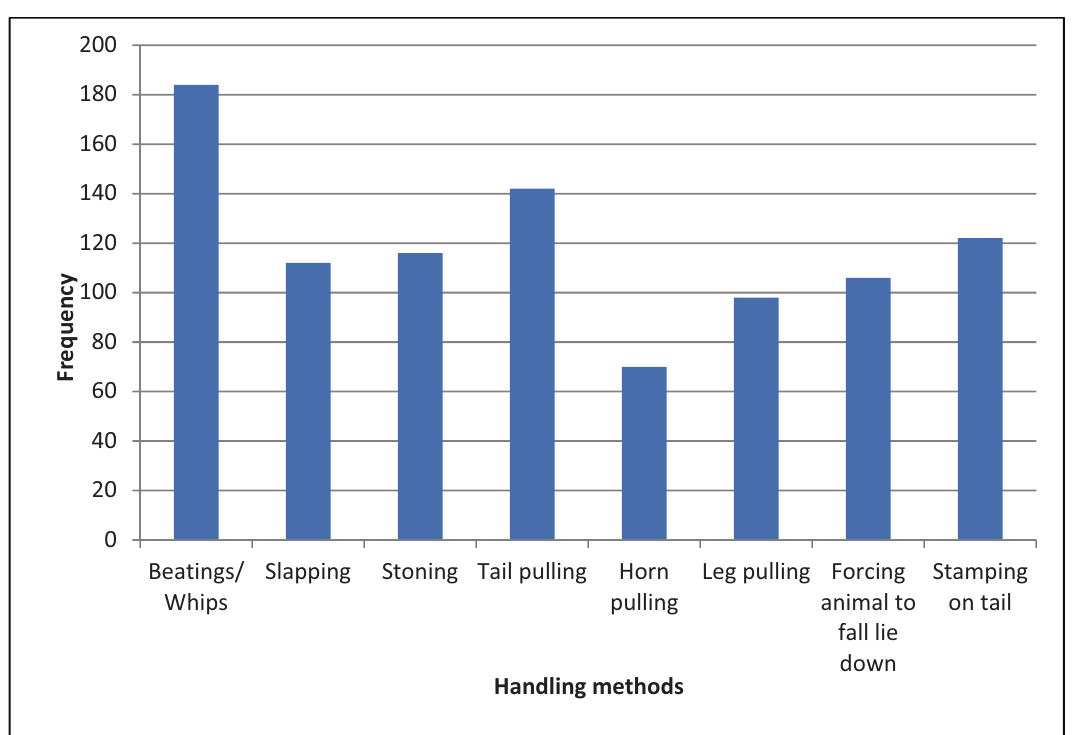
Figure 2. Frequency of occurrence of ways of handling cattle (n = 200) as they were being moved from the cattle market into the